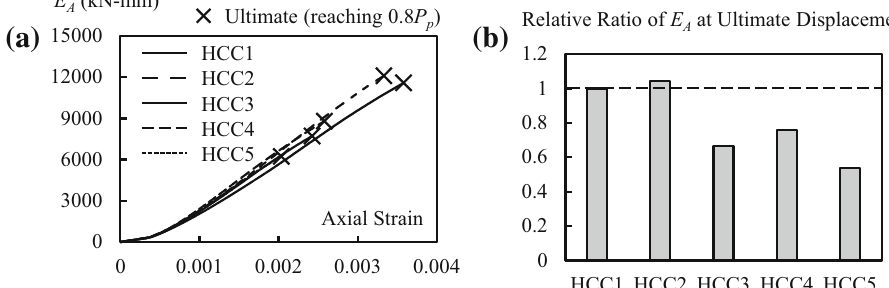
Fig. 11 Energy absorption capacities of column specimens: a axial strain–energy dissipation relationship and b comparison of energy dissipation at ultimate